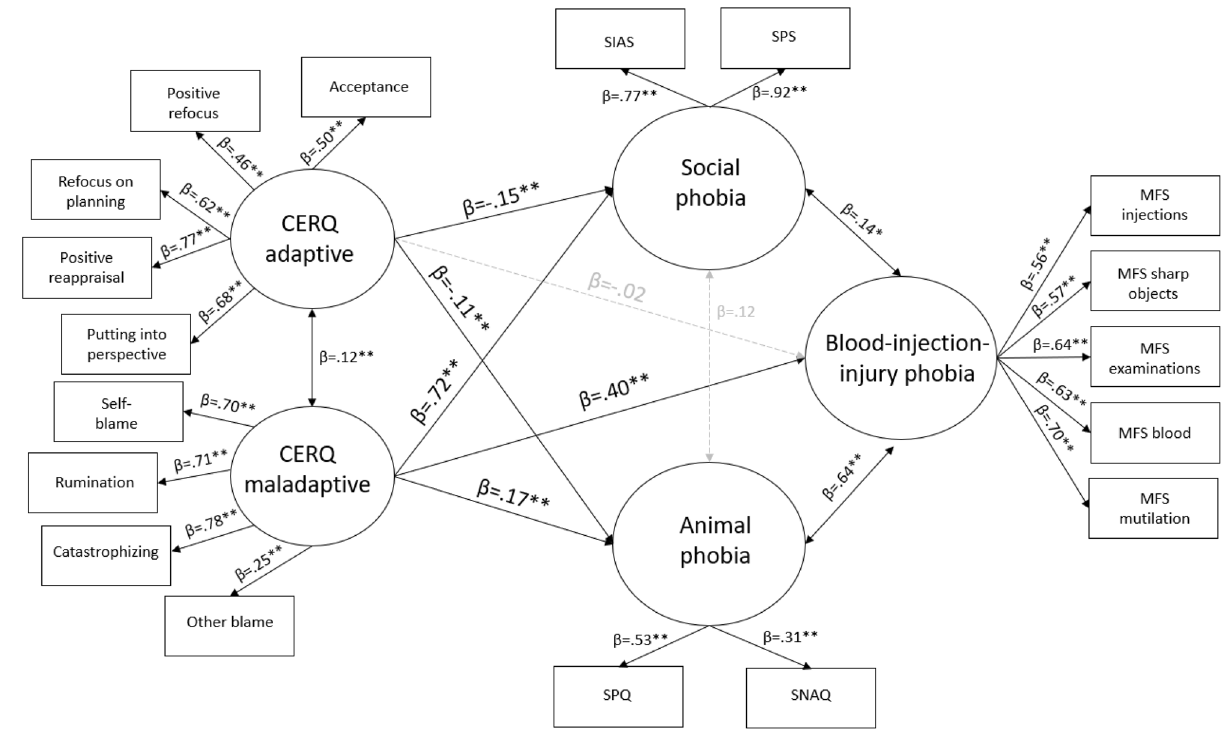
Figure 1. Our proposed model on the connection and background mechanisms of different phobias. All paths included in the analysis are displayed. All reported estimates are the maximum likelihood standardized point estimates. Statistically significant unstandardized point estimates are highlighted in black (*p < 0.05; **p < 0.001). Grey lines indicate a nonsignificant pathway. CERQ Cognitive Emotion Regulation Questionnaire, SPS Social Phobia Scale, SIAS Social Interaction Anxiety Scale, SNAQ Snake Phobia Questionnaire, SPQ Spider Phobia Questionnaire, MFS Medical Fear